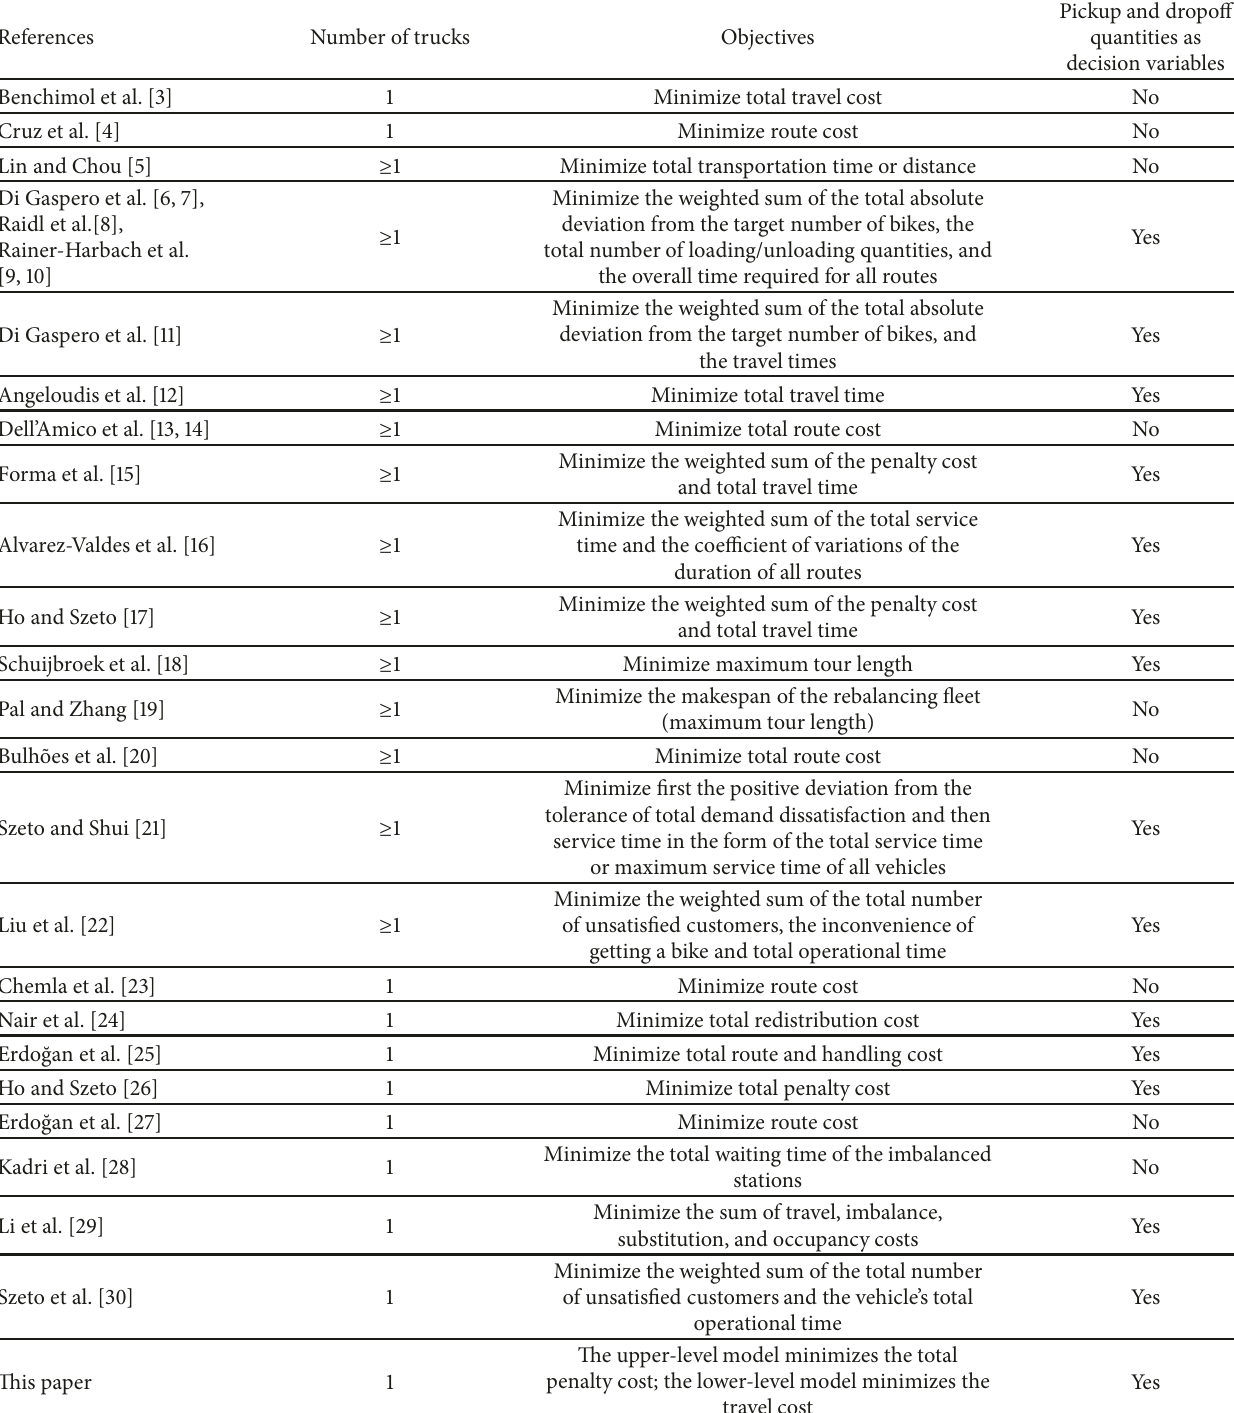
Table 1: Summary of the static BRP in the